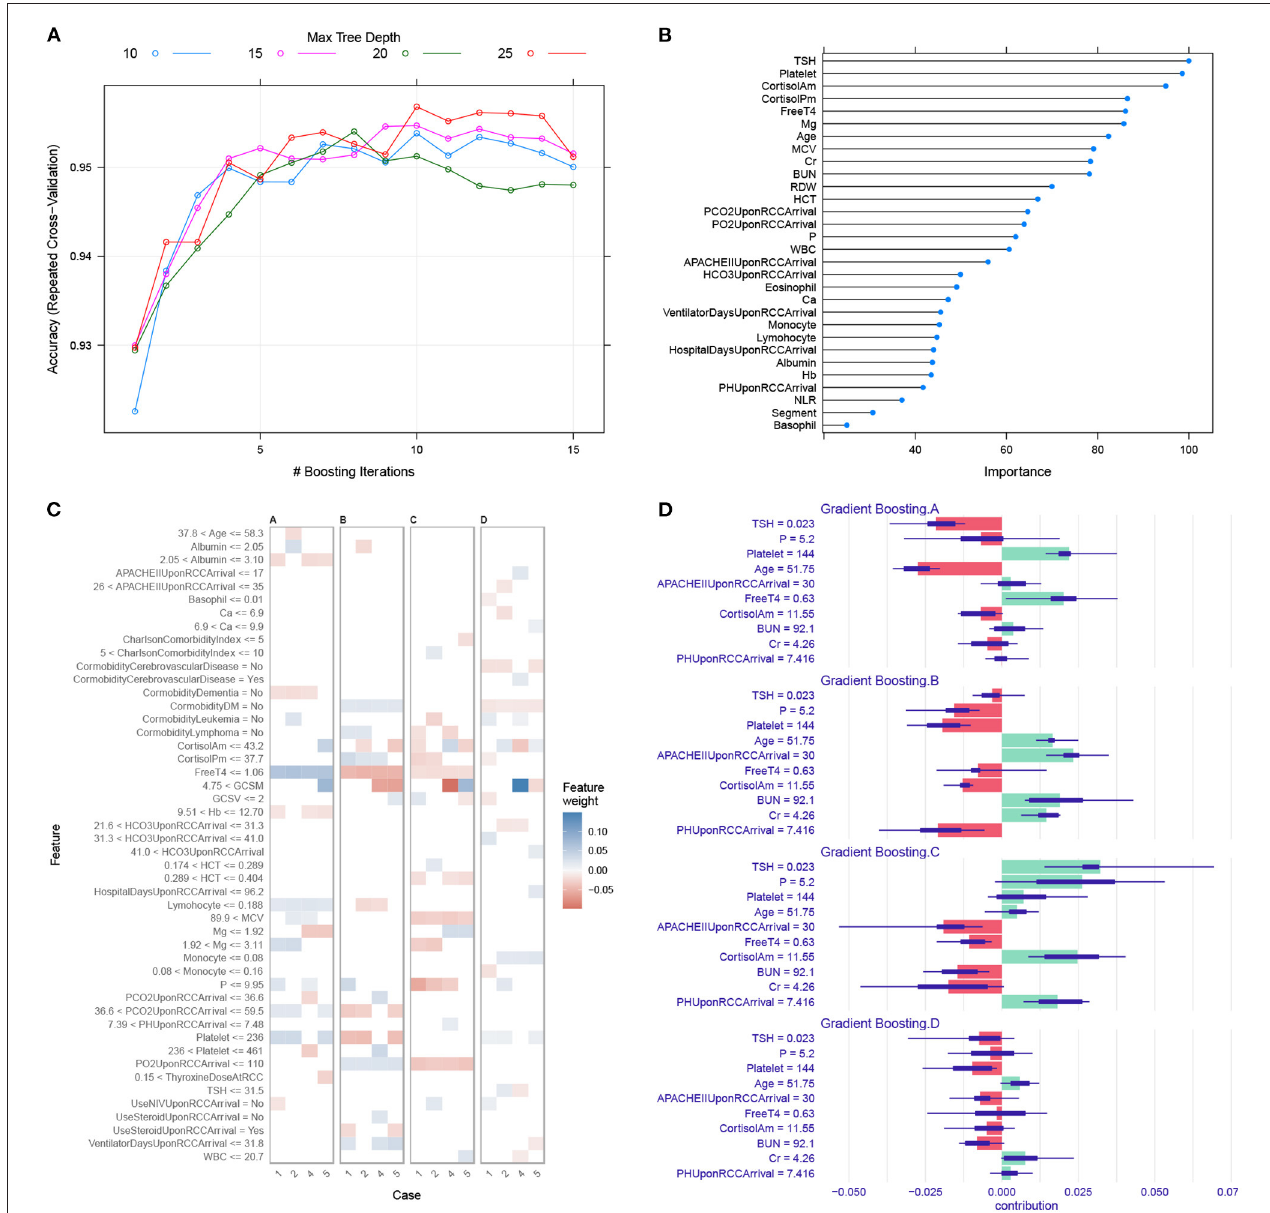
FIGURE 3 | Gradient boosting machine training and interpretation. (A) Hyperparameter tuning for the gradient boosting machine model. We used grid search strategy to select hyperparameters with the highest accuracy. (B) Variable importance in the GBM model. Higher importance value indicates greater influence of the variable in differentiating the clusters. (C) LIME interpretation for four sample subjects. The horizontal axis is labeled by the sample ID. The observed cluster membership for patients 1, 2, 4 and 5 were A, B, C and D respectively. Blue (red) color indicates the variable is supporting for (contradicting against) a given cluster. For example, the subject 4 has magnesium < 1.92 supporting for cluster C. (D) The iBreakdown explainer for patient #4 showed that there was more support for allocation to cluster C than to other clusters. The feature TSH = 0.023 strongly supports its assignment to cluster C, whereas the APACHE II = 30 on RCC arrival contradicts its assignment to cluster C. The short bar indicates the confidence interval for uncertainty. LIME, local interpretable model-agnostic explanations; HCT, hematocrit; WBC, white blood cell count; BUN, blood urea nitrogen; Cr, creatinine; RDW, red distribution width; MCV, mean corpuscular volume; GCS, Glasgow coma scale; GCSM, motion component of